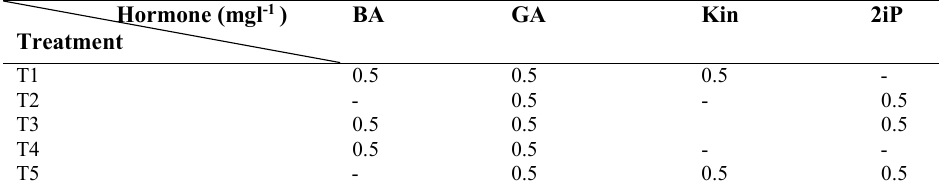
Table 1. Shooting different treatments of E. globules.